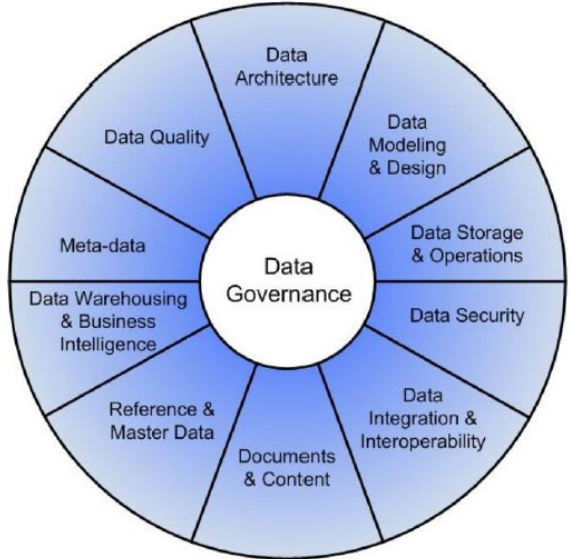
Figure 4. DAMA-DMBOK2 Framework (DAMA International,